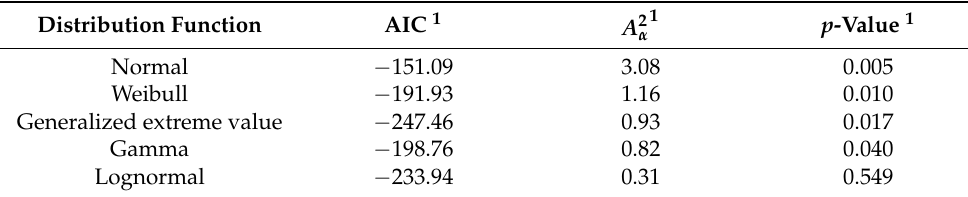
Table 1. Performances of five probability distribution functions for the rainfall fraction of the first